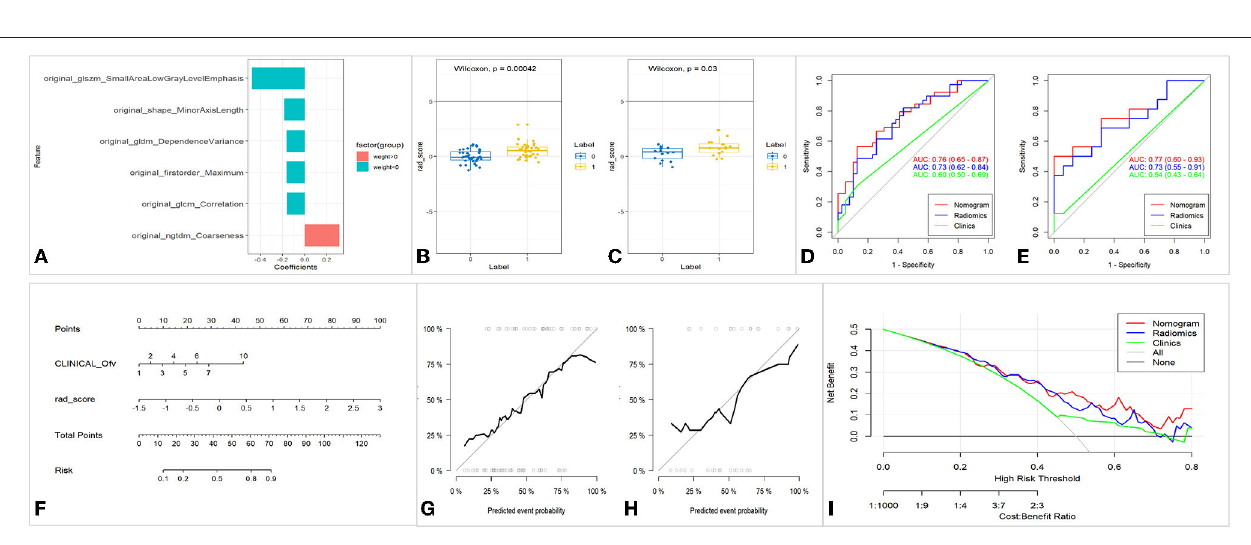
FIGURE 4 | Feature selection, model construction, and evaluation of UC-ITN ROI with NVC on the unaffected side. (A) Wilcoxon’s test of the rad_score between the two groups of trigeminal-nerve cisternal segment feature selection and importance ratio. (B,C) Wilcoxon’s test of rad_score in the training and validation cohorts. (D,E) The ROC of the three models of the training and validation cohorts, respectively. (F) Nomogram. (G,H) Calibration curves of the training and validation cohorts, respectively. (I) Decision curve. ROC, receiver operating characteristic curve; 1, 2, 3, 4, 5, 6, 7, and 10 of the INCLINICAL_Ofv represent the superior cerebellar artery, anterior superior cerebellar artery, anterior inferior cerebellar artery, vertebral artery, basilar artery, superior cerebellar artery and anterior superior cerebellar artery, superior cerebellar artery and anterior inferior cerebellar artery, and tiny vascular that are hard to identify, respectively; Ofv, offending vascular; UC-ITN, unilateral classical Trigeminal neuralgia or idiopathic trigeminal neuralgia with NVC; ROI, region of interest; NVC, neurovascular